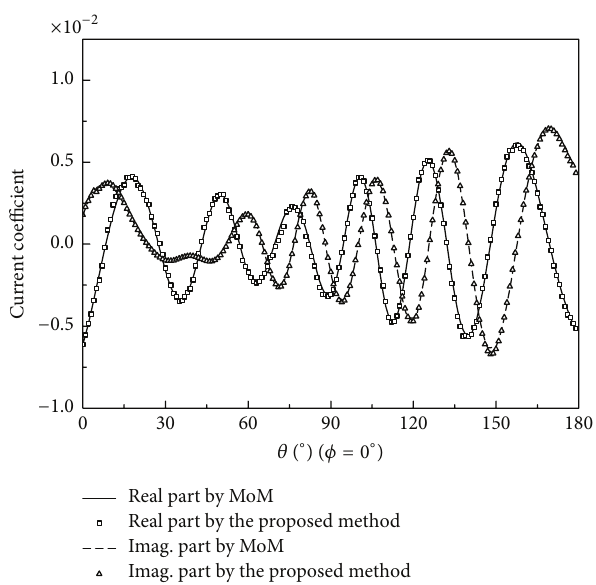
Figure 2: True and recovery current coefficients for Almond